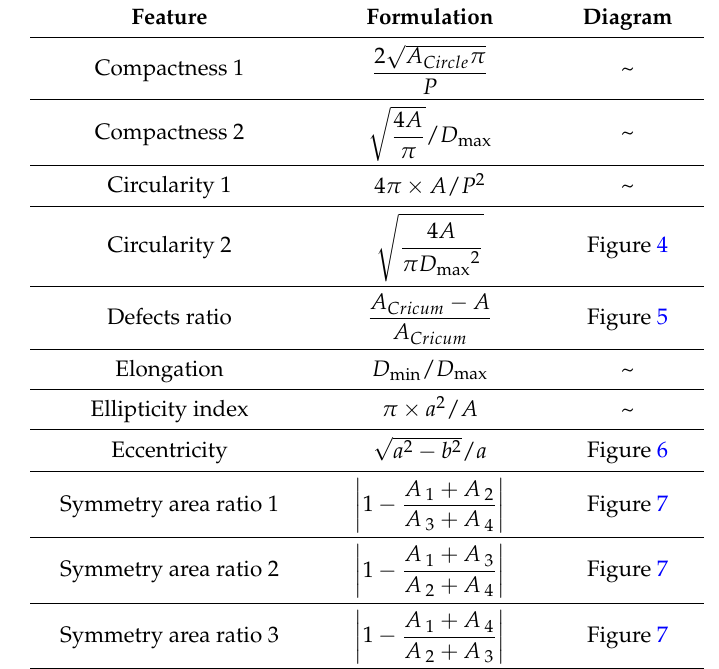
Table 1. Mathematical formulations of shape features.